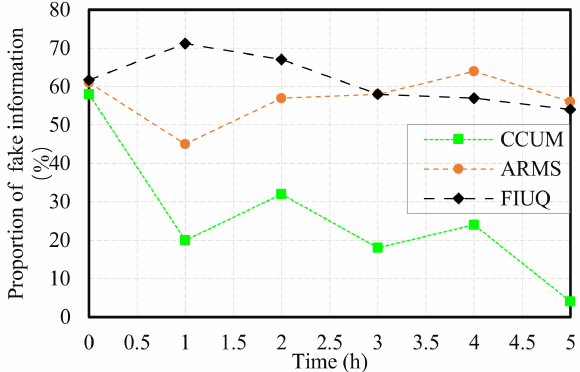
Figure 7. The proportion of fake